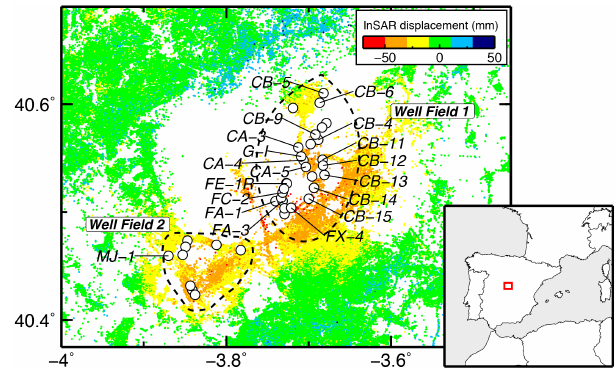
Figure 1. Location map and data distribution over the study re- gion. InSAR deformation corresponding to an extraction episode from January 1999 to April 2000 is shown in the background. Black dashed lines outline the two well fields in the